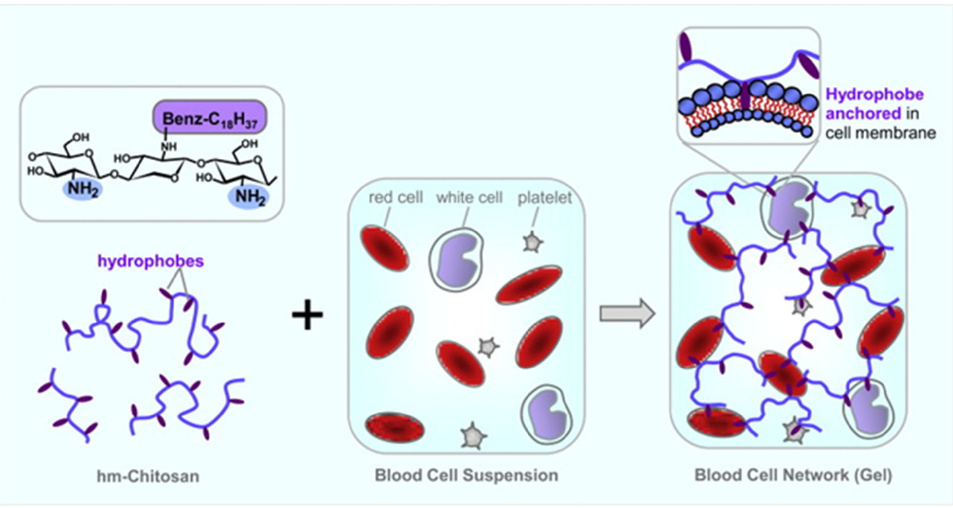
Figure 4. Mechanism for gelation of blood by alkylated chitosan [49].